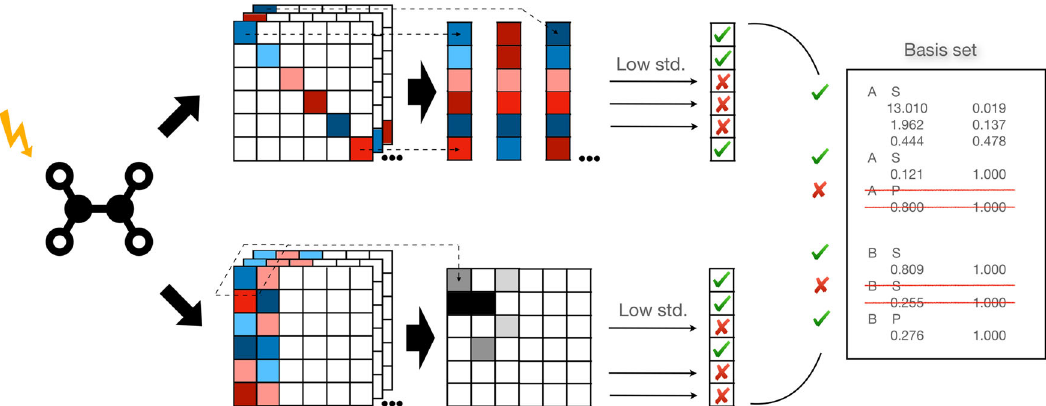
based on the low standard deviation (std. in the fi gure) of O μ ( t ) and C μ j ( t ). Even- tually, one can directly modify the basis set fi le for a complete RT-TDHF/TDDFT calculation or a LR-TDHF/TDDFT